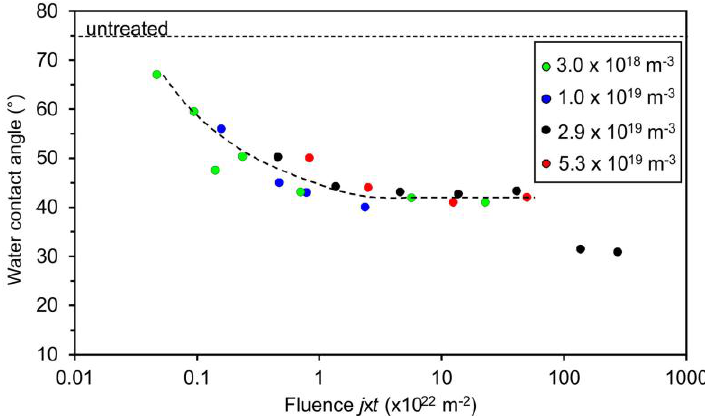
Figure 2. Variation of the water contact angle of the plasma-treated acryl-coated PP with the fluence of oxygen atoms. The different colors represent experiments with different O-atom densities.